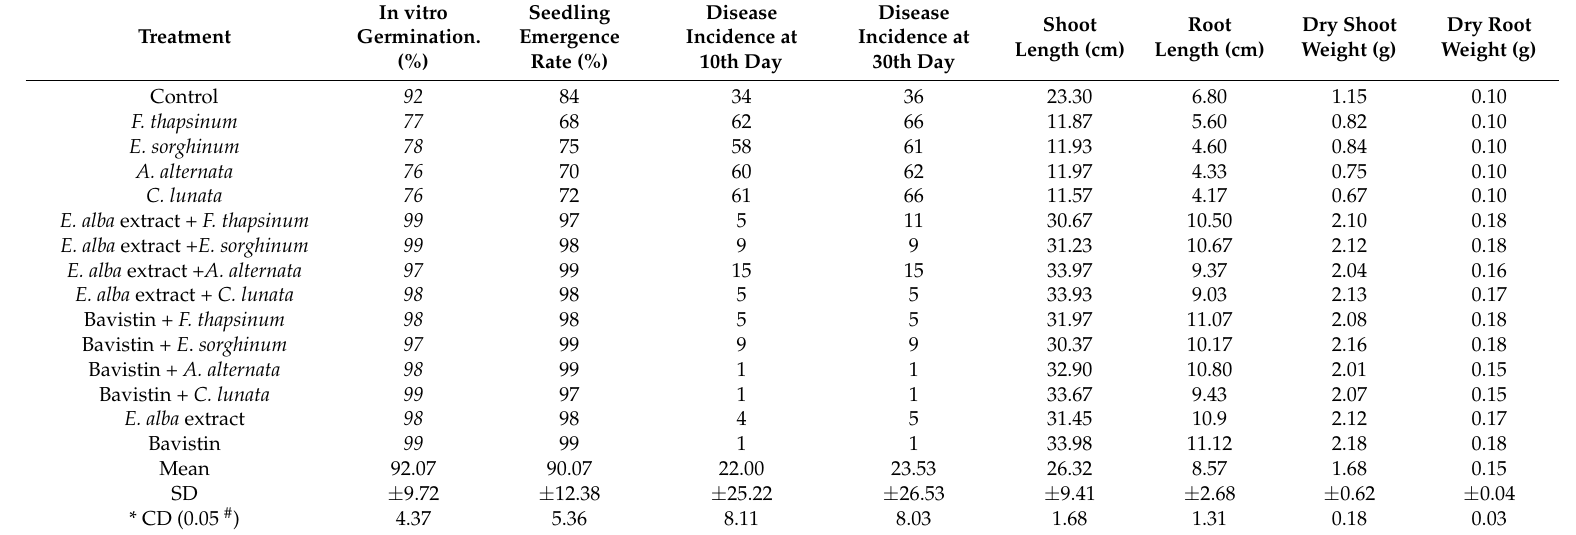
Table 3. Influence of purified E. alba methanol extract on sorghum pathogens and growth parameters under greenhouse condition. In vitro Treatment